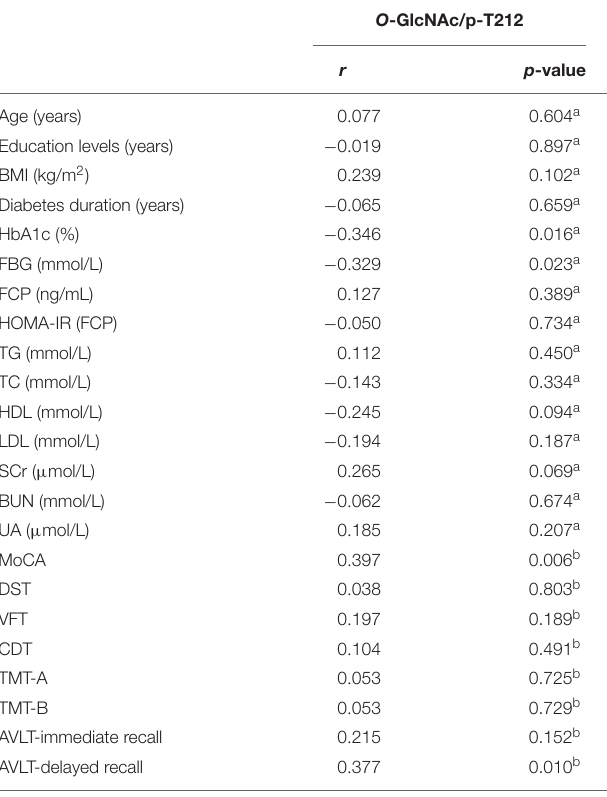
TABLE 3 | Relationships of O -GlcNAc/p-T212 with other clinical characteristics and different cognitive domains performances in T2DM patients. O -GlcNAc/p-T212 r p